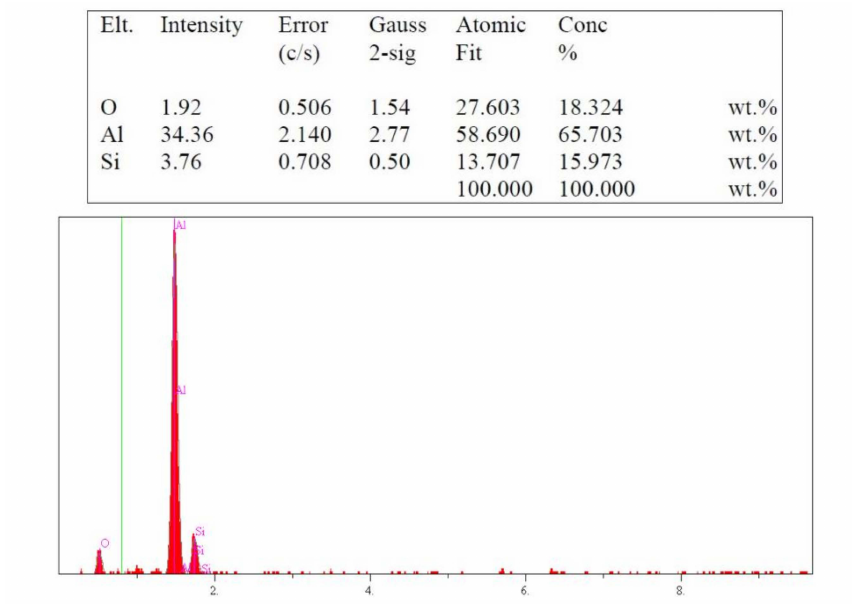
Figure 16. SEM and EDX analysis of pore inner